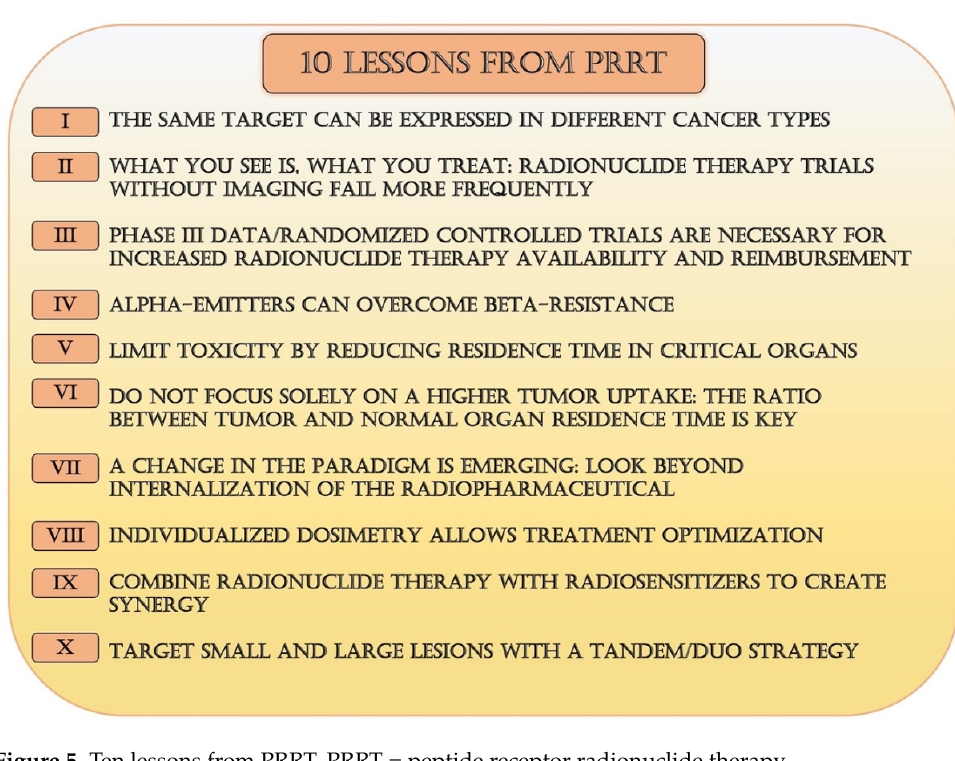
Figure 5. Ten lessons from PRRT. PRRT = peptide receptor radionuclide